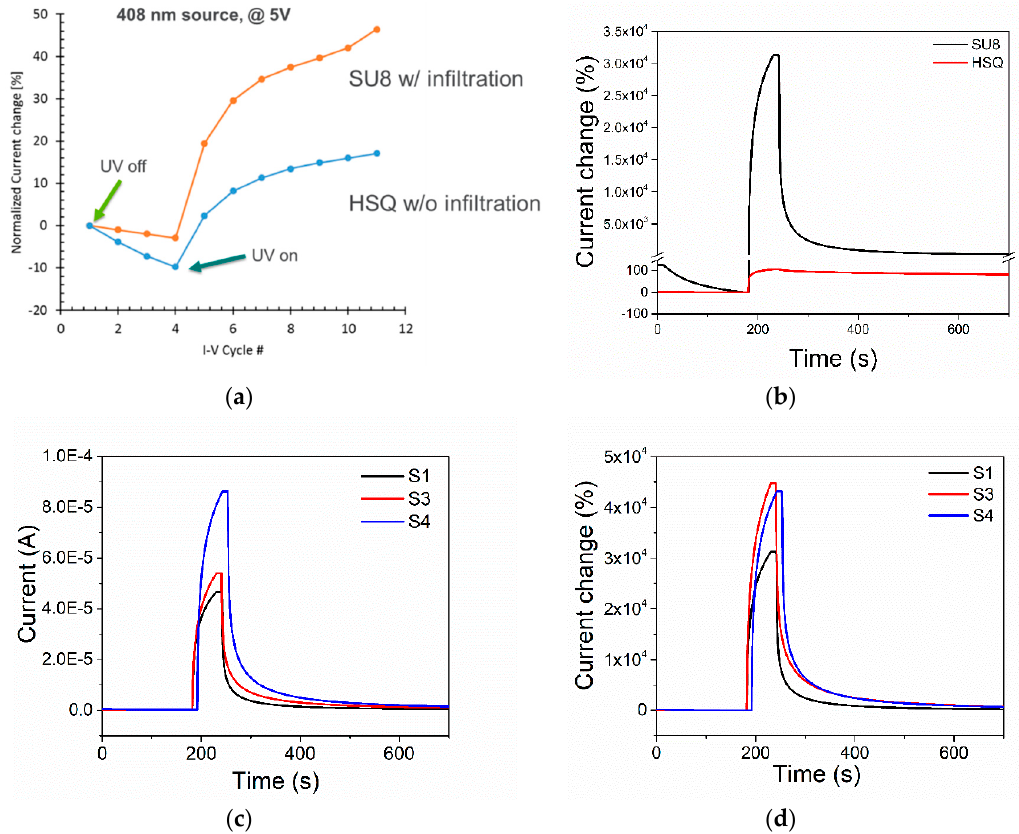
Figure 5. ( a ) Change of current at 5 V when turning on UV LED at 408 nm in 30 s intervals for devices with the hydrogen silsesquioxane (HSQ) dielectric core with/without w/o infiltration, and with photoresist polymer (SU-8) with infiltration. ( b ) Change of current vs. time when turning on UV lights for devices with a HSQ dielectric core, and with SU-8 polymer. ( c , d ) Change of current vs. time for infiltrated devices with SU-8 polymer taken at 2 V. S1 recipe: H 2 O, BA-MeOH, H 2 O; S3 recipe: (DEZ, H 2 O) × 2 cycles, BA-MeOH, H 2 O; S4 recipe: (DEZ, H 2 O) × 2 cycles, (BA-MeOH, H 2 O) × 2 cycles. ( c ) Current vs. time showing actual current in Amps. ( d ) Percentage change of current vs. time normalized to the average current before turning on the UV light